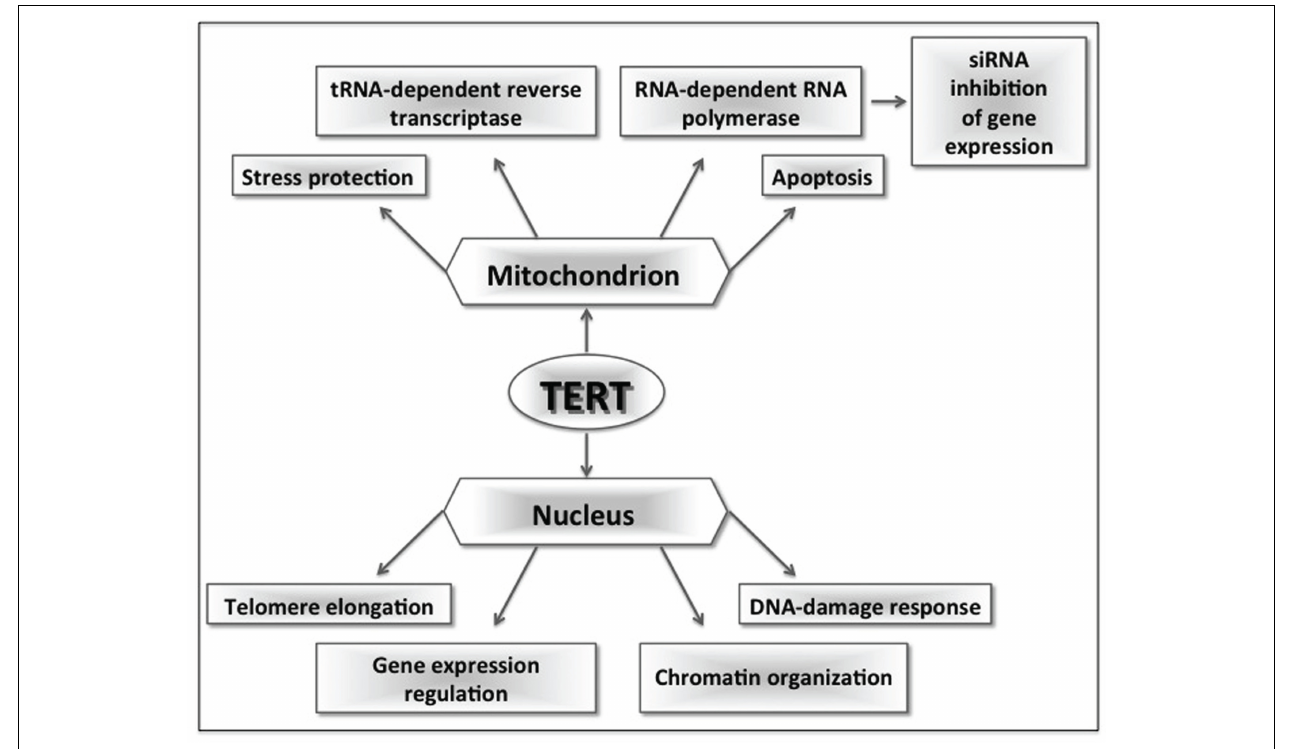
plays a role in stress response, apoptosis, and in the maintenance of mitochondrial fitness; moreover, it can interact with RNAs other thanTERC acquiring an additional RNA transcriptase activity or an RNA-dependent RNA polymerase activity.This last activity seems to lead the production of siRNAs that are involved in post-transcriptional gene expression